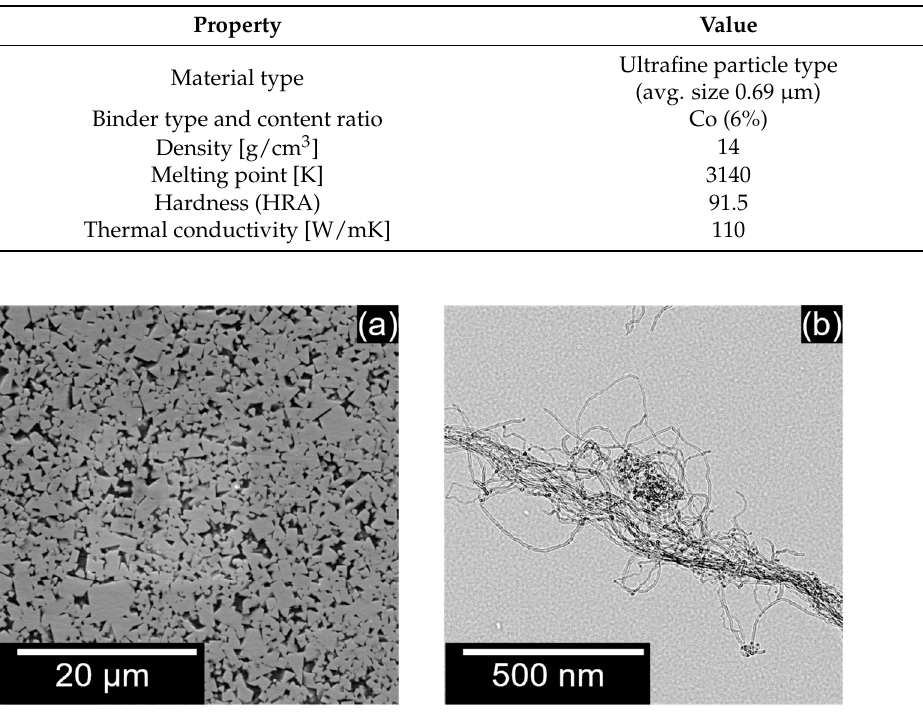
Figure 3. SEM of ( a ) tungsten carbide, TEM of ( b ) carbon nanofiber, ( c ) alumina, ( d ) silicon particles. 3.3. Powder Materials Three different powders of varying shapes, densities and electrical properties were used in this experiment. Commercially available polishing grade alumina powder, Baikalox 1CR, manufactured by Baikowski International Co. Ltd., was used as the insula ‐ tor powder. Semiconductive silicon powder, manufactured by Kyocera, Japan, was used. Lastly, carbon nanofibers of diameter 10–20 nm and height 0.1–10 μ m, produced by Mitsubishi Chemicals, Japan, were used as a conductive powder in this experiment. The transmission electron micrographs [TEM] of carbon nanofiber, alumina, and silicon are shown in Figure 3b–d, respectively. A laser particle analyzer from Horiba semiconduc ‐ tors, LA ‐ 960, was used to measure the particle size. Figure 4a,b show the size distribution of the silicon and alumina powders, respectively. The thermal and electric properties of the powder are listed in Table 2. Table 2. Properties of different powders. Property